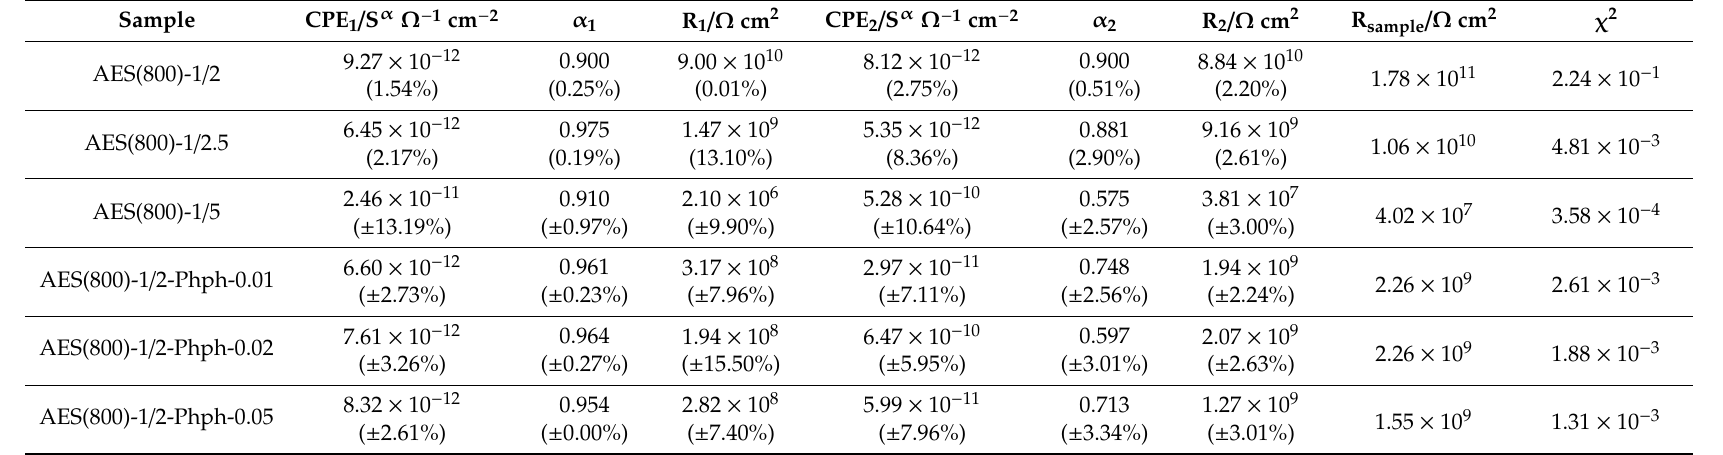
Table 3. EEC data parameters values obtained by fitting the EIS response obtained for both doped and undoped films (Figures 5–8).